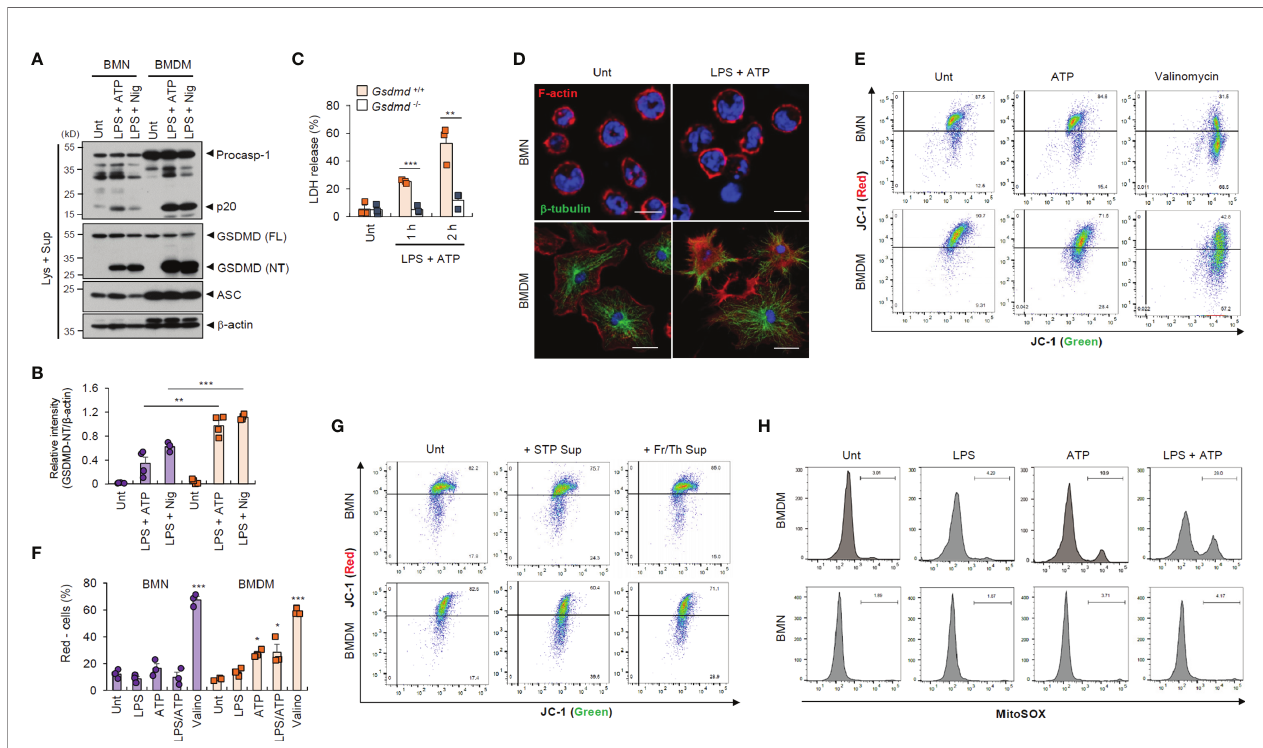
FIGURE 3 | Neutrophils exhibit weaker gasdermin D cleavage and mitochondrial depolarization than macrophages in response to NLRP3 stimulation. (A) Immunoblots from mouse BMNs or BMDMs untreated (Unt) or primed with LPS (0.25 m g/mL, 2.5 h), followed by ATP (2.5 mM, 1h) or nigericin (Nig, 5 m M, 1 h) treatment. (B) Quanti fi cation of relative GSDMD (NT) band intensity versus b -actin band in (A) . ( n = 4). (C) Quanti fi cation of LDH release into the culture supernatants of wild-type or Gsdmd -de fi cient mouse BMDMs primed with LPS followed by ATP (2.5mM, 1 or 2 h) treatment ( n = 3). (D) Representative immuno fl uorescence images of mouse BMNs or BMDMs treated with LPS followed by ATP (2mM, 1 h) treatment after staining with anti-F-actin (red) and anti- a -tubulin (green) antibodies. Nuclei were stained with DAPI (blue). Scale bars, 10 m m (BMNs) or 20 m m (BMDMs). (E) Flow cytometric analysis of mouse BMNs or BMDMs treated with ATP (2.5mM, 30 min) or valinomycin (5 m M, 30 min) treatment after JC-1 staining. (F) Quanti fi cation of JC-1 (red)-negative mouse BMDM or BMN populations treated with LPS alone, ATP alone, LPS followed by ATP or valinomycin ( n = 3). (G) Flow cytometric analysis of mouse BMDMs or BMNs treated with cell-free supernatants of untreated cells or those injured by staurosporine treatment or repeated freeze/thaw cycles for 1.5 h after JC-1 staining. (H) Flow cytometric analysis of mouse BMDMs or BMNs treated with LPS alone (0.25 m g/mL, 2.5 h), ATP alone (2.5mM, 0.5 h) or LPS followed by ATP treatment after MitoSOX staining. GSDMD; gasdermin D, FL; full length, NT; N-terminal. * P < 0.05, ** P < 0.01, *** P <